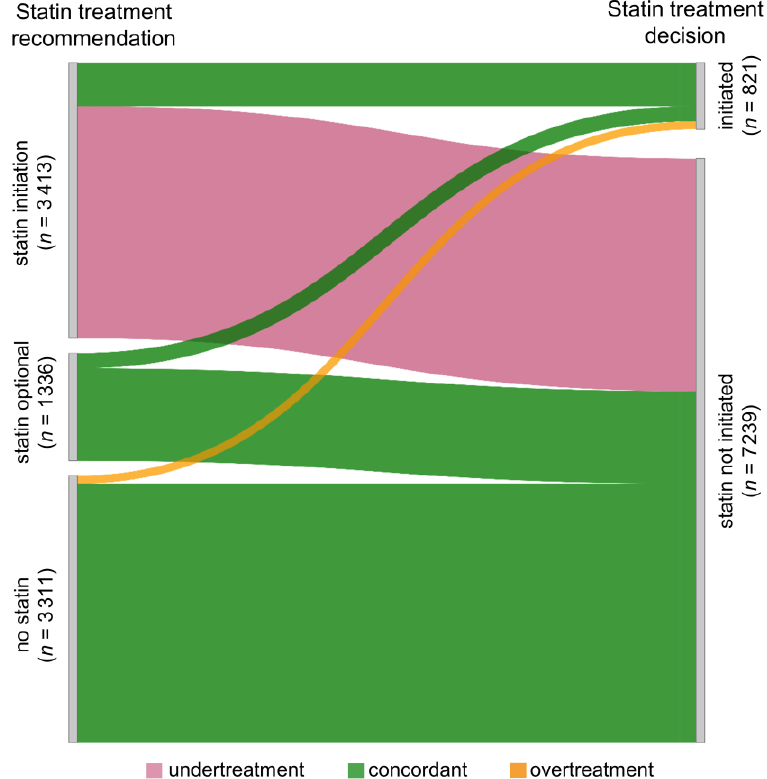
Figure 3. Guideline concordance of statin treatment decisions. The flows represent the patients’ statin treatment recommendations and decisions; the size of the flows is proportional to the number of patients (total n = 8060). The colors indicate the concordance of recommendation and treatment: green indicates guideline-concordant treatment, pink indicates undertreatment and orange indicates overtreatment.